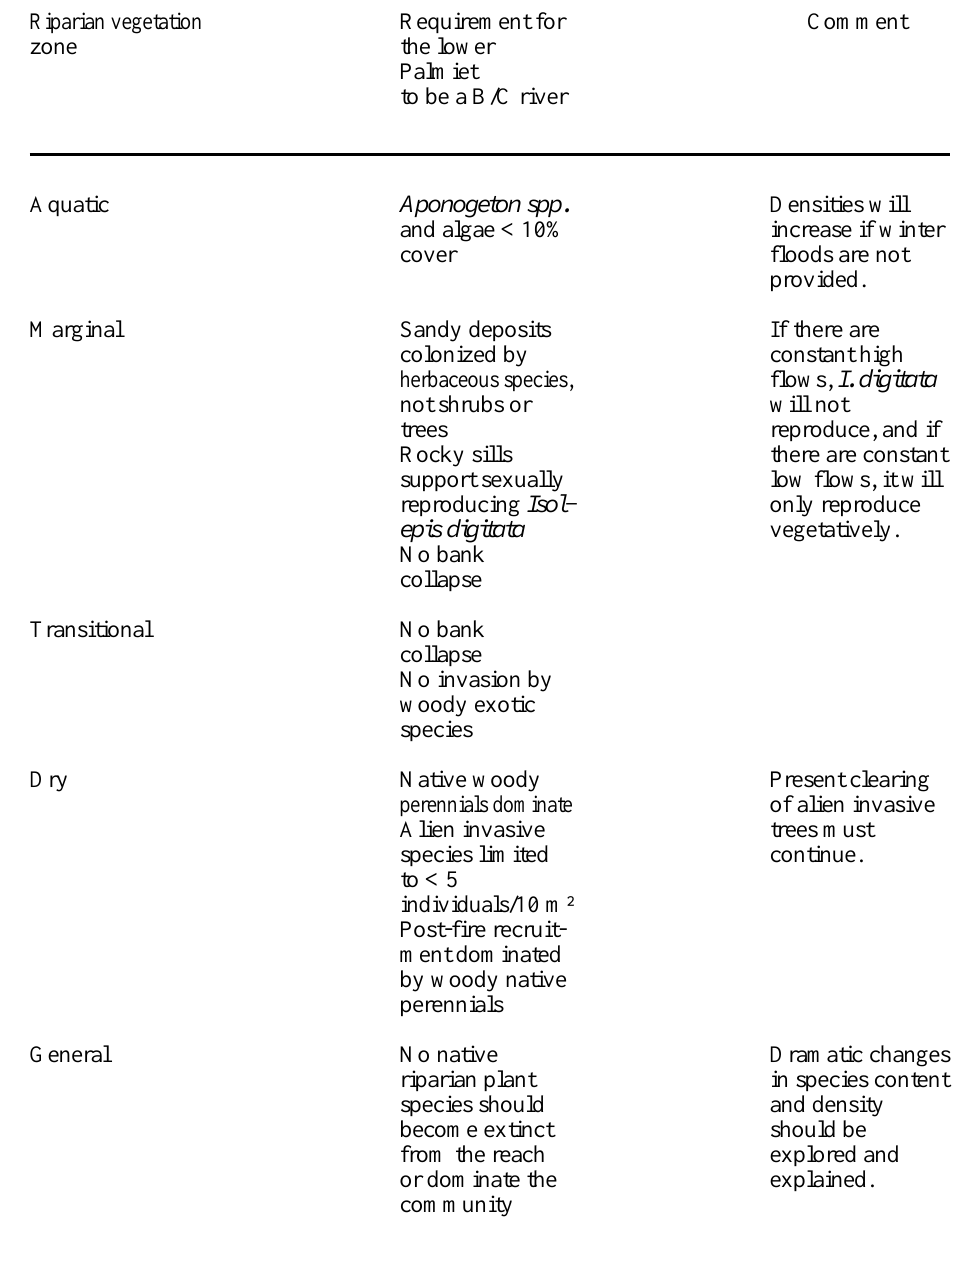
Table 12 . Resource quality objectives for riparian vegetation categorized as B/ C for the lower Palmiet River, Western Cape (modified from Boucher and Tlale 2000). For an explanation of the categories, please see Table